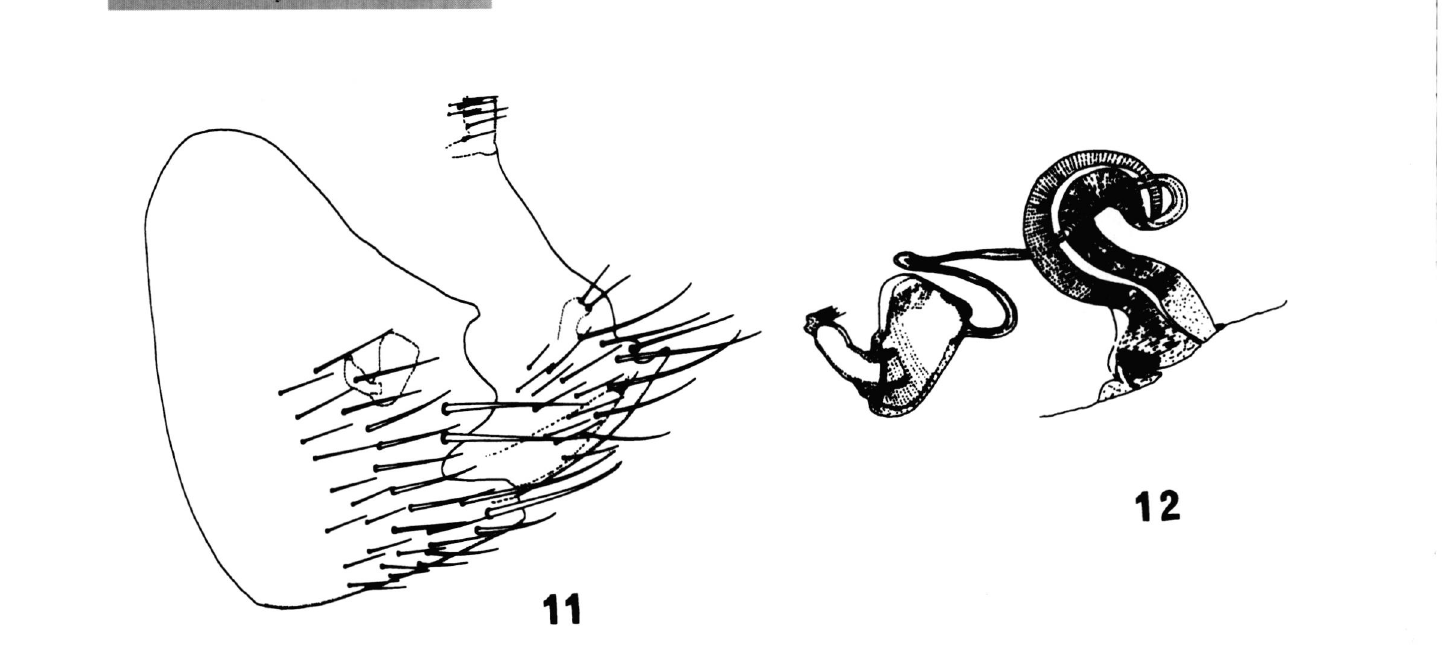
Fig. 6 à 12. - Stivalius franciscae Beaucournu et Durden n. sp. - 6 : partie antérieure de la capsule céphalique (Holotype - ex Rattus hoff manni, Indonesia, Central Sulawesi, Douggala, Paku (1°17'S - 120°04 E), 955 m, 1 novembre 1974 [B 897931); 7 : sternite VIII (Holotype); 8 : tergite IX, apex du basimère et telomere {ex Bunomyspenitus, femelle (ex R